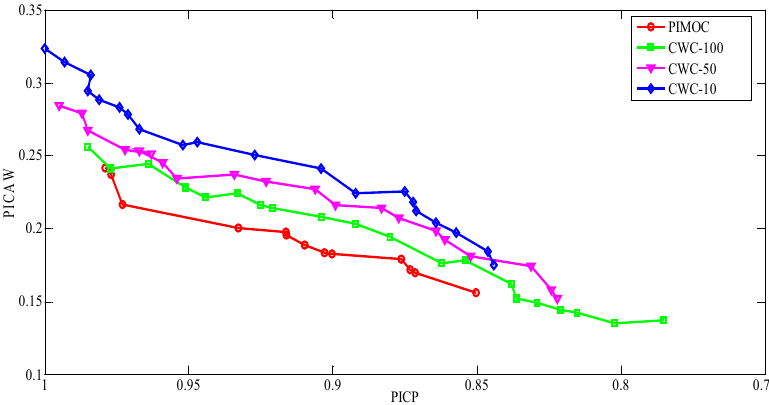
Figure 2. Comparative results between CWC and PIMOC. CWC: coverage width-based criterion;